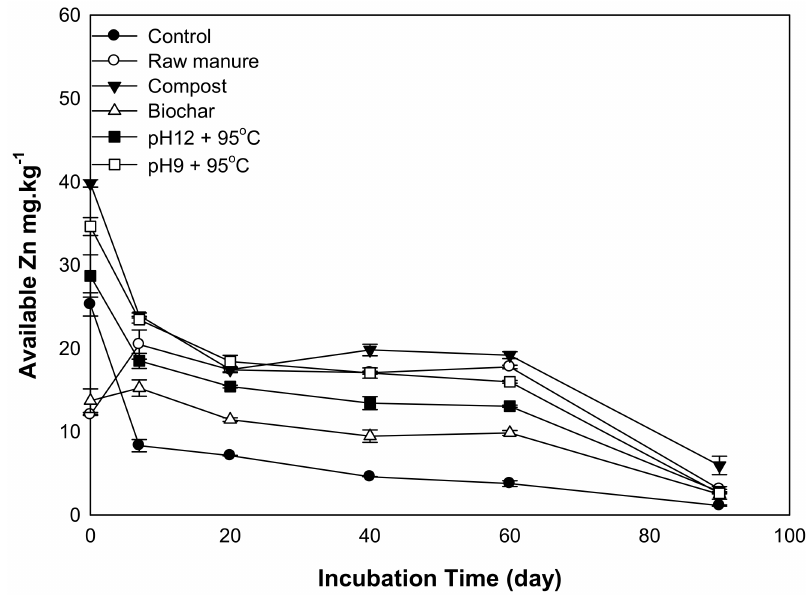
Figure 6. Soil available Zinc affected by different organic amendments derived from cow manure at different incubation